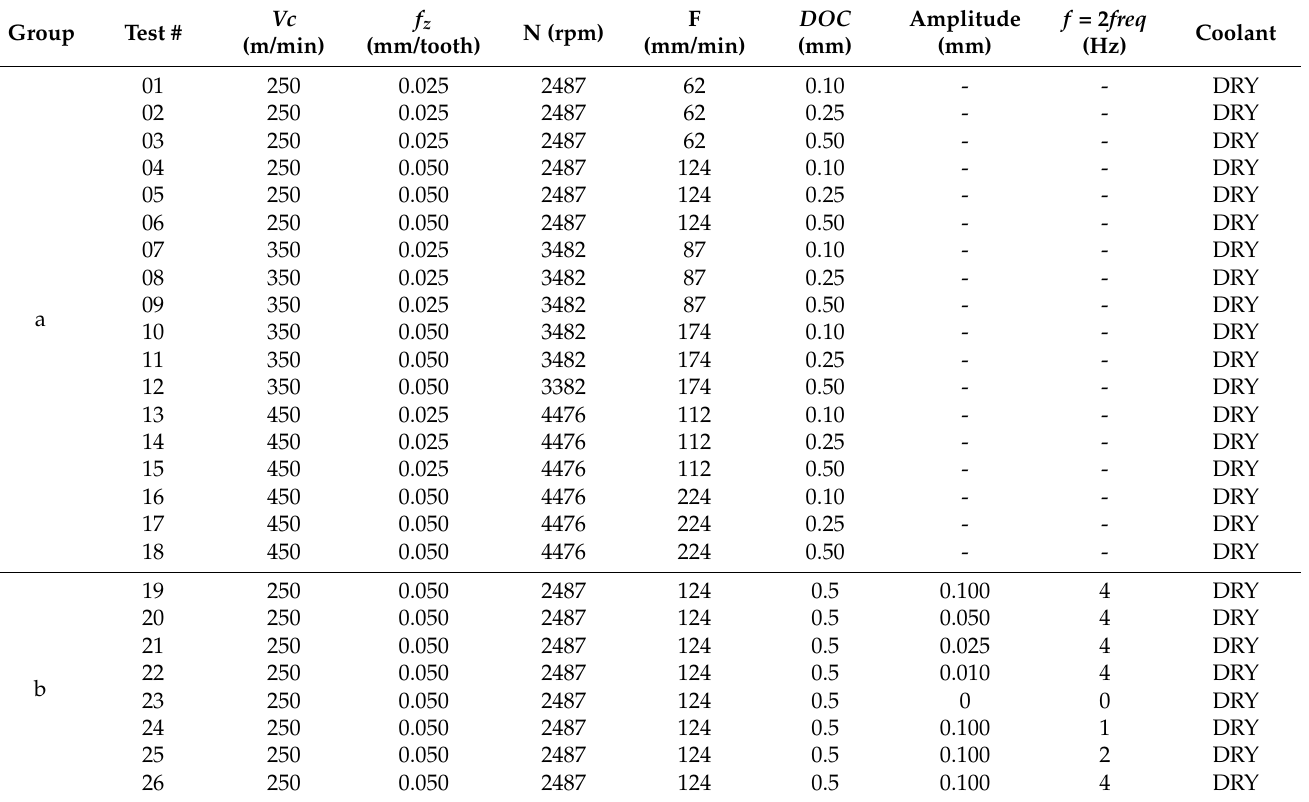
Table 2. Conventional cutting conditions. LFAB cutting conditions.